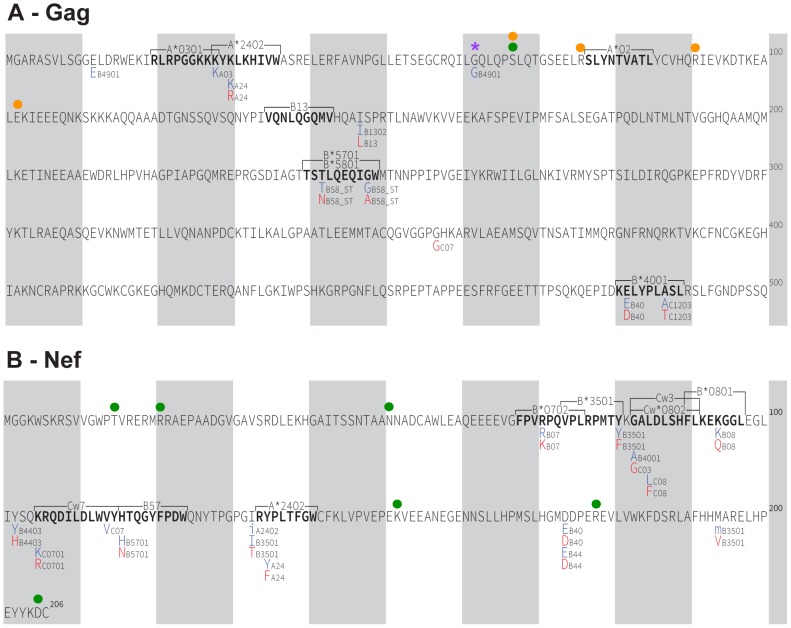
HLA-associated polymorphisms, identified via statistical association, in historic HIV sequences.
Panel A: Gag immune escape map, indicating the locations, specific amino acid residues and HLA restrictions of HLA-associated polymorphisms identified at q≤0.05 in our historic cohort. The HIV consensus B amino acid sequence is used as a reference. Shaded vertical bars separate blocks of 10 amino acids. “Adapted” amino acids (those over-represented in the presence of the HLA allele) are red. “Nonadapted” amino acids (those under-represented in the presence of the HLA allele) are blue. UPPERCASE letters distinguish polymorphisms that survive correction for HIV codon covariation (“direct” associations), while lowercase letters distinguish polymorphisms that do not survive correction for codon covariation (“indirect” associations). The notation “_ST” following an HLA (e.g. B58_ST) identifies associations identified at the supertype level. The locations of optimally-defined, HLA-restricted CTL epitopes straddling or adjacent to HLA-associated polymorphisms are indicated. The well-known A*02-SL9 epitope (SLYNTVATL) epitope is also shown; no historic HLA-associated polymorphisms were identified therein at q<0.05. The single “novel” historic HLA-associated polymorphism (B*49:01-62G) is indicated with a purple asterisk. A green filled circle denotes the single Gag residue (codon 67) where the ancestral founder sequence was reconstructed with <80% confidence. Orange filled circles denote the four Gag residues (67, 76, 91 and 102) where the inferred ancestral founder sequence differs from the published North American subtype B consensus sequence. None of these sites harbor HLA associations. Panel B: Nef historic immune escape map. Green filled circles denote the six Nef residues where the ancestral founder sequence was reconstructed with <80% confidence (15, 21, 51, 152, 178, 205); none harbor HLA associations.